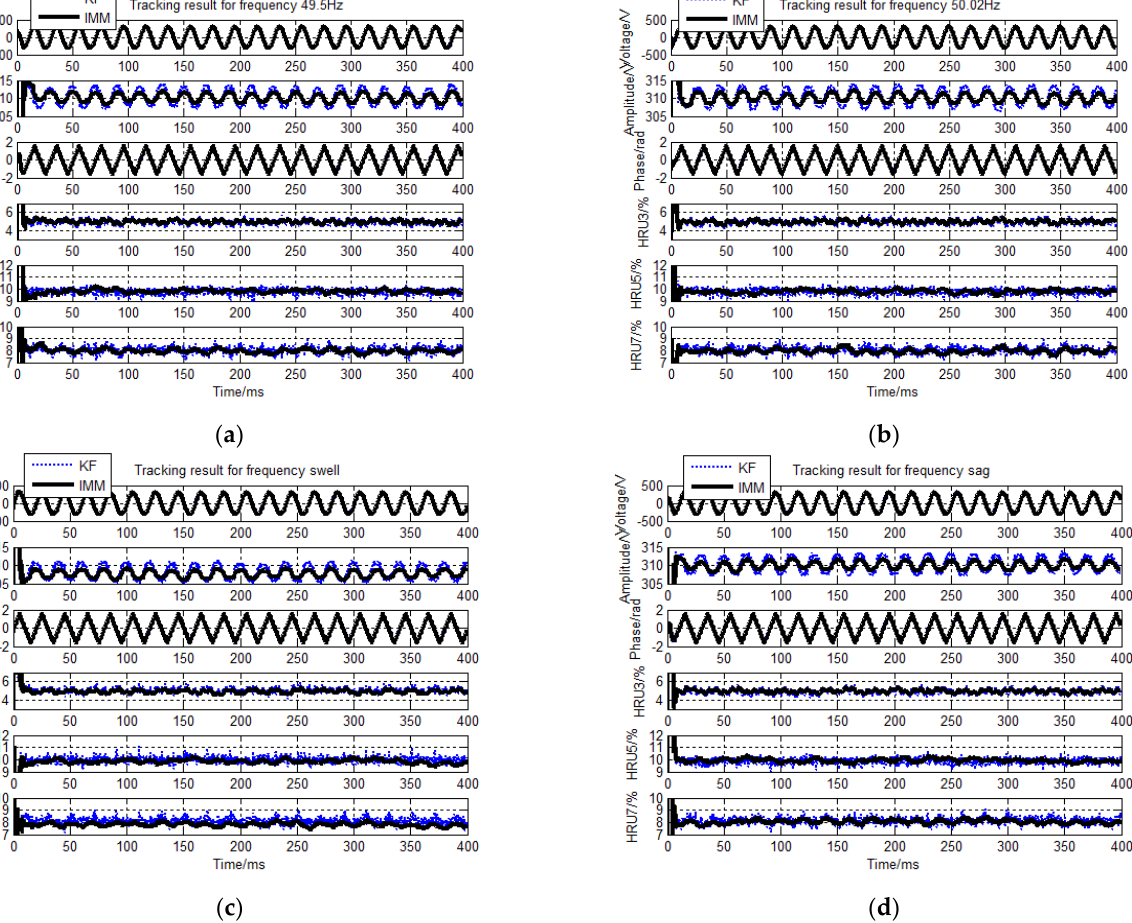
Figure 15. Experiment tracking results for voltage frequency slight fluctuations. ( a ) Experiment tracking results for frequency 49.98 Hz; ( b ) Experiment tracking results for frequency 50.02 Hz; ( c ) Experiment tracking results for frequency swell; ( d ) Experiment tracking results for frequency sag.